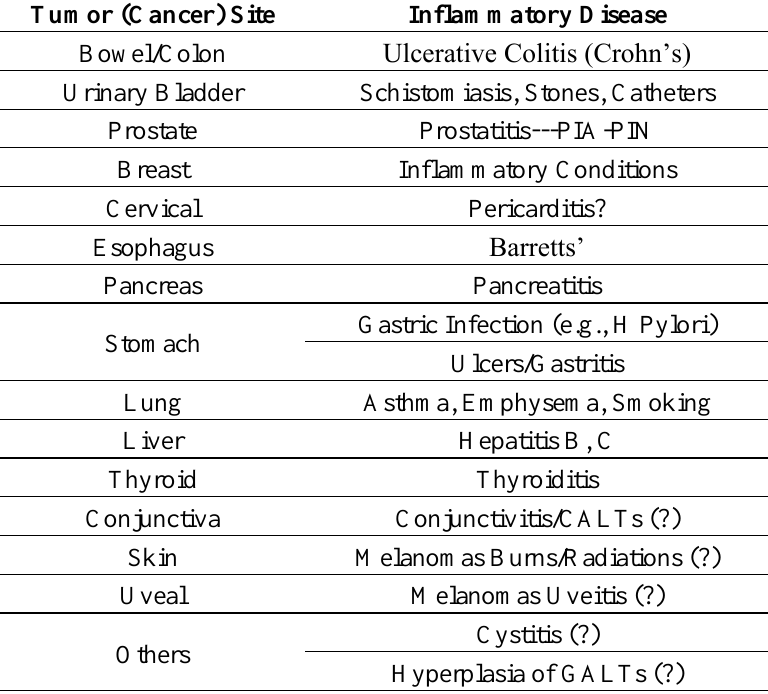
Table 1. Growing list of reported data on clinical and epidemiological findings for circumstantial evidence on association between chronic prior injuries and site-specific